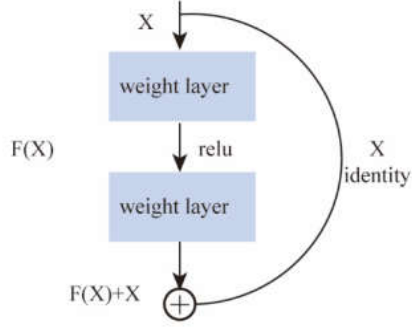
Figure 3. Residual learning: a building block.